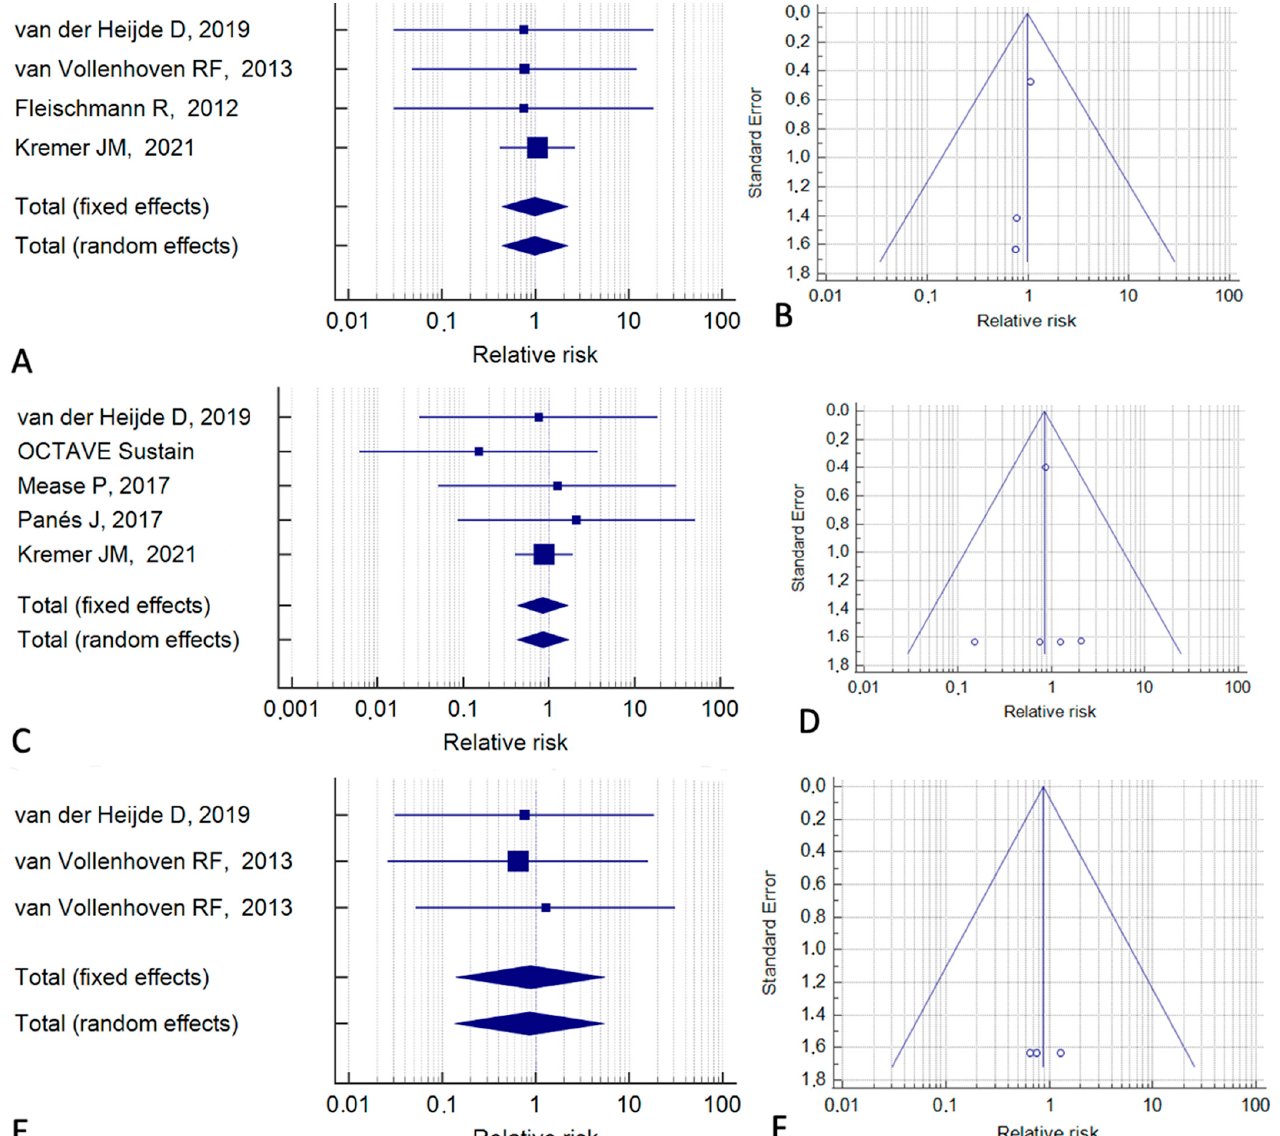
Figure 4. Meta ‐ analyses for di ff erent types of cancer. ( A , B ) Lung cancer. ( C , D ) Breast cancer. ( E , F ) Figure 4. Meta-analyses for different types of cancer. ( A , B ) Lung cancer. ( C , D ) Breast cancer. Cervical cancer [2,20,24,25,35,36,39]. ( E , F ) Cervical cancer